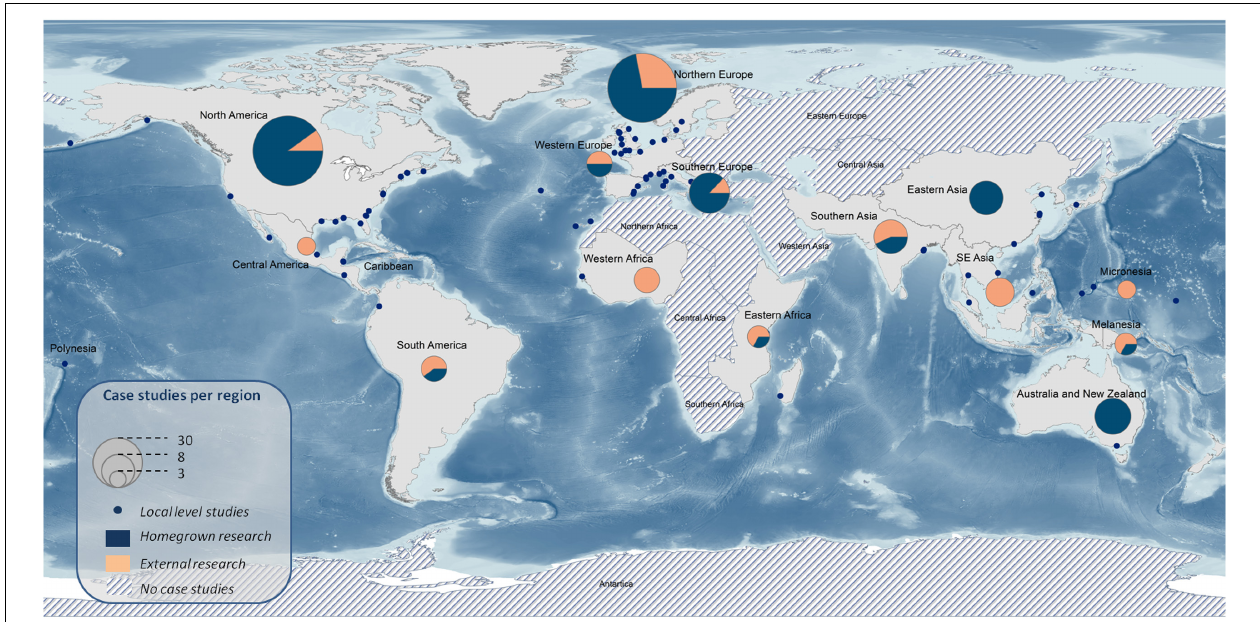
FIGURE 1 | Map illustrating the study locations carried on CMES according to location and the affiliation of the first authors. The pie size represents the number of studies carried out per region and the points depict the location of case studies. The colors within the pie show the percentage of studies carried out by researchers from the same region (blue), or from different regions (orange). In Central and South Africa, as well as West and Central Asia no CMES assessments have been found. Reproduced from Liquete et al. (2013); open access under the Creative Commons Attribution License - CC BY 4.0).